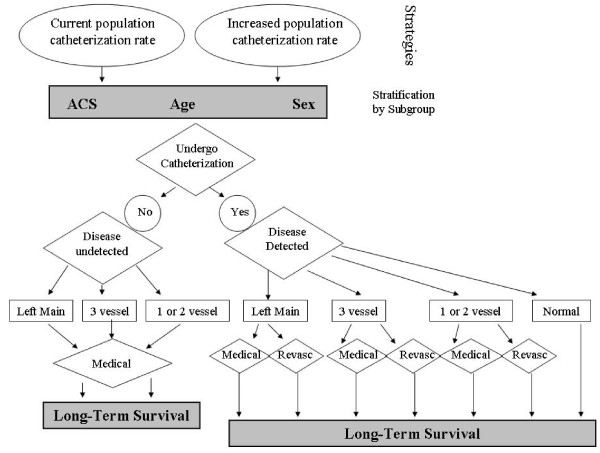
Model structure.